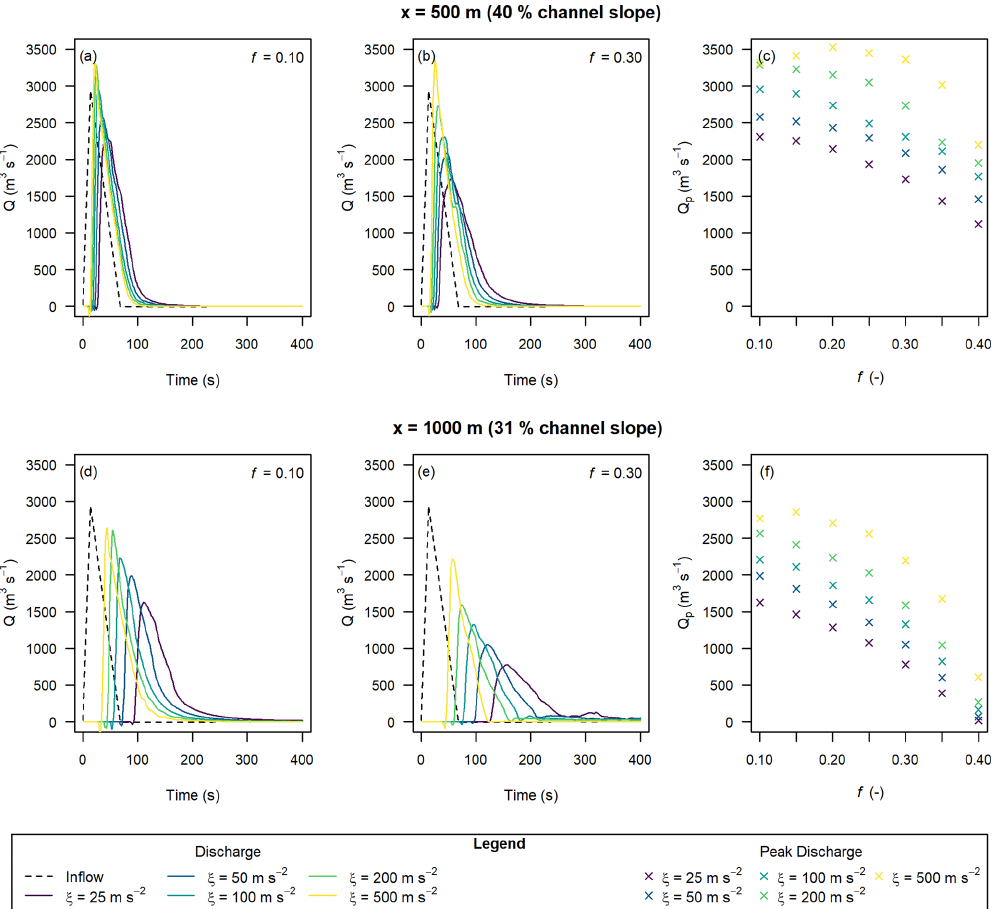
Figure 6. Hydrographs extracted at x = 500m (a–c) and x = 1000m (d–f) with varying Voellmy parameters and Q p = 2940m 3 s − 1 , based on triangular input